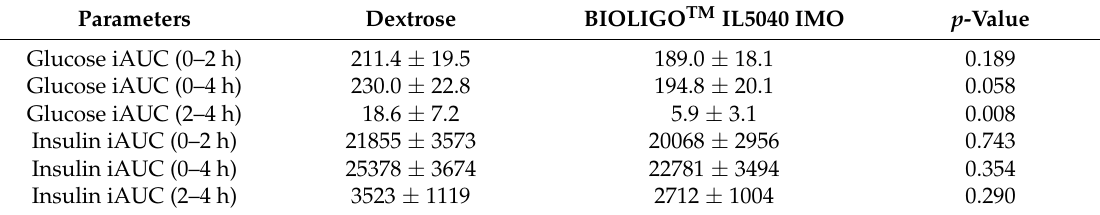
Table 4. Incremental area-under-curve (iAUC) for glucose and insulin (Study 1). Parameters Dextrose BIOLIGO TM IL5040 IMO p